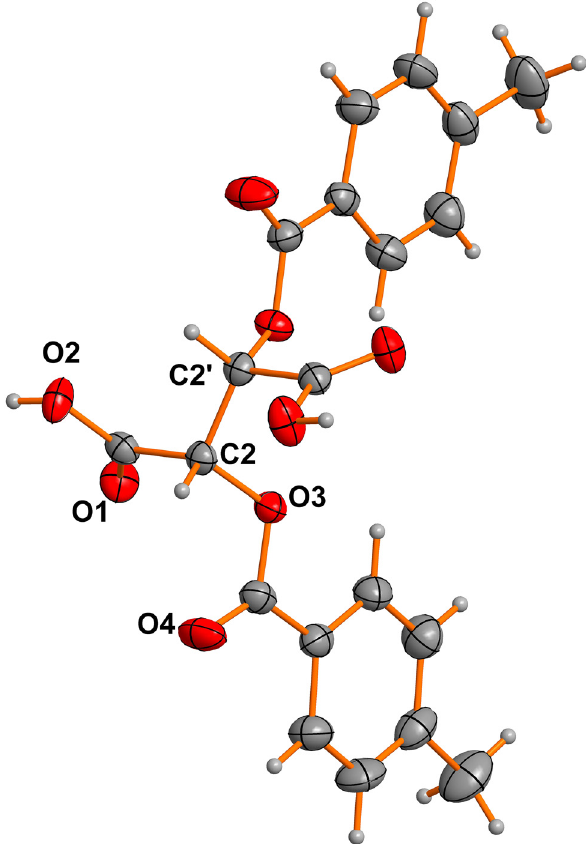
Table 1 contains crystallographic data and Table 2 contains the list of the atoms including atomic coordinates and displacement parameters.